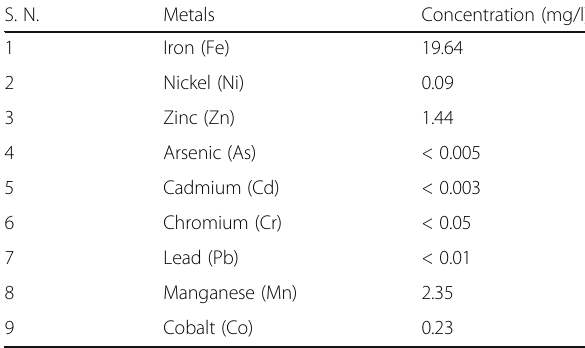
Table 2 Concentration of different heavy metal (mg/l) in a plant sample S.